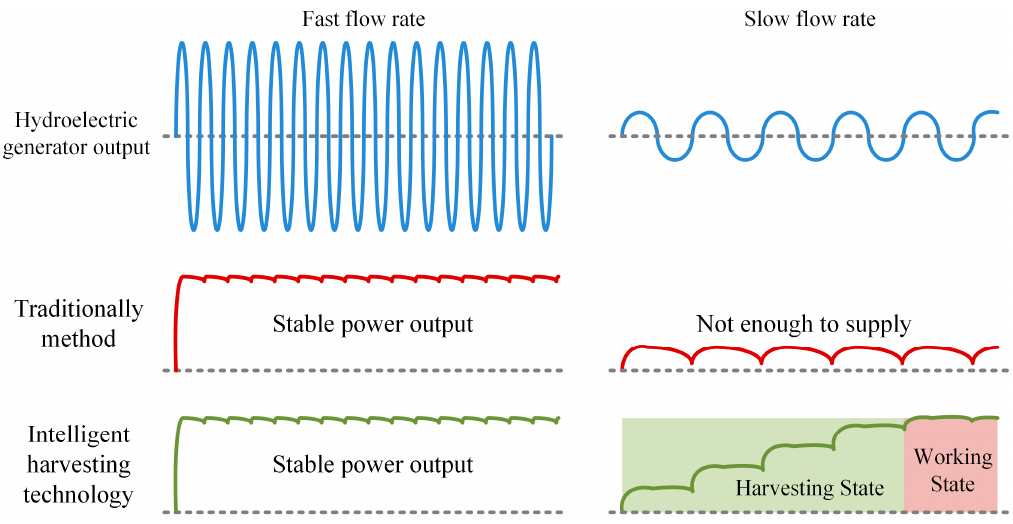
Figure 1. Output power comparison with fast and slow flow rates.